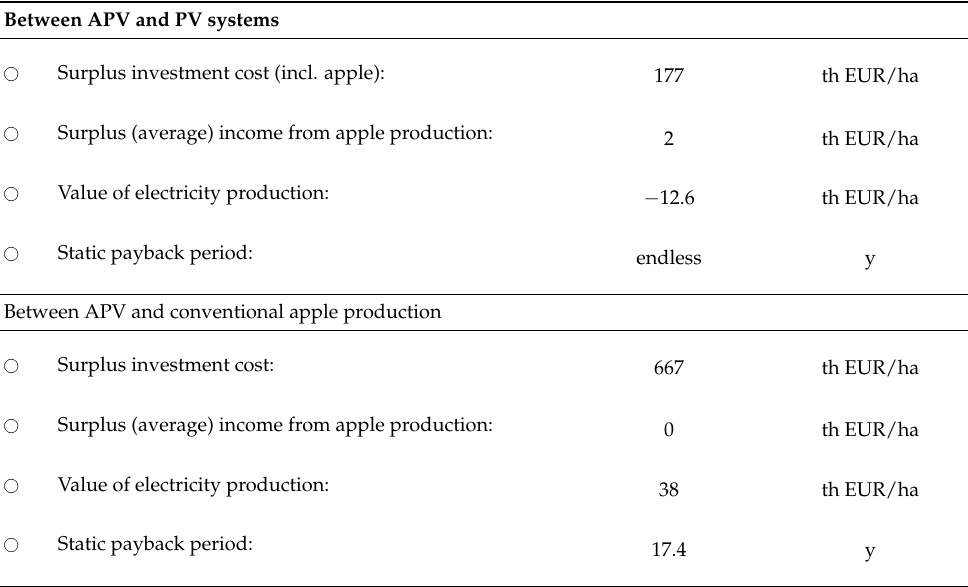
Table 6. Economic results of the comparative analyses in the baseline scenario.